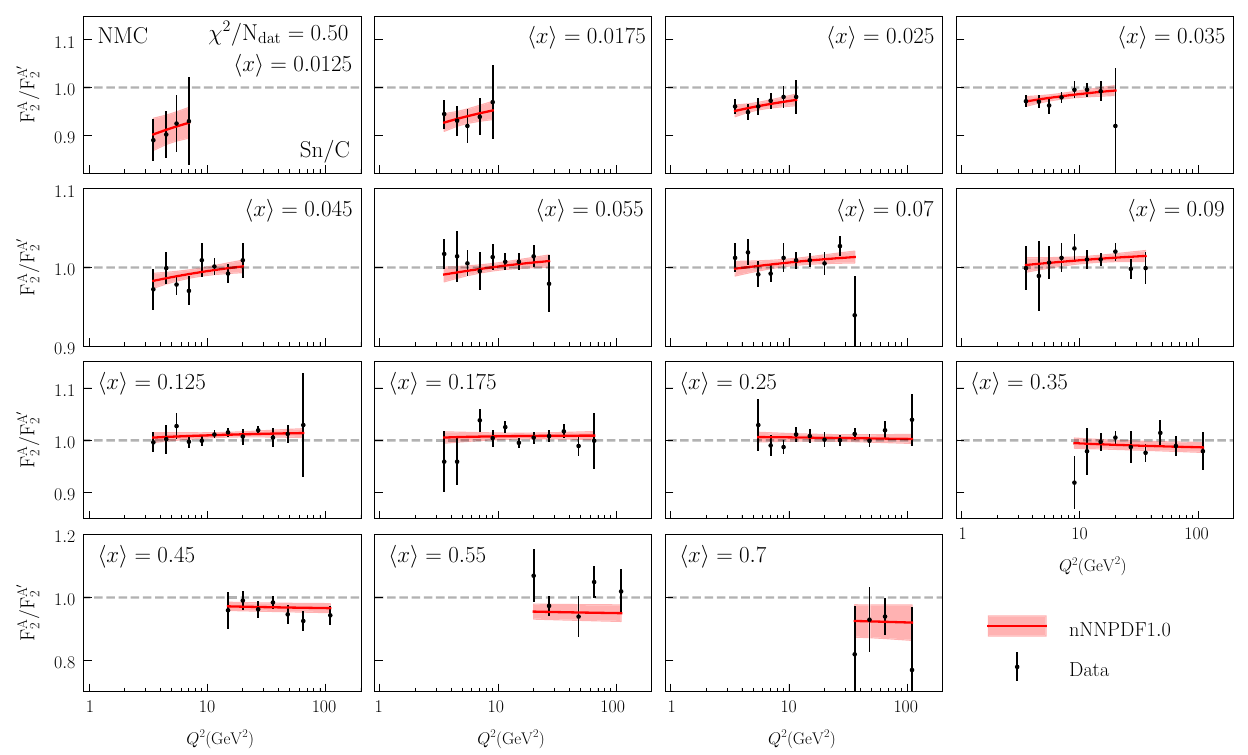
Fig. 14 Same as Fig. 13 but for the Q 2 -dependent structure function ratio F Sn